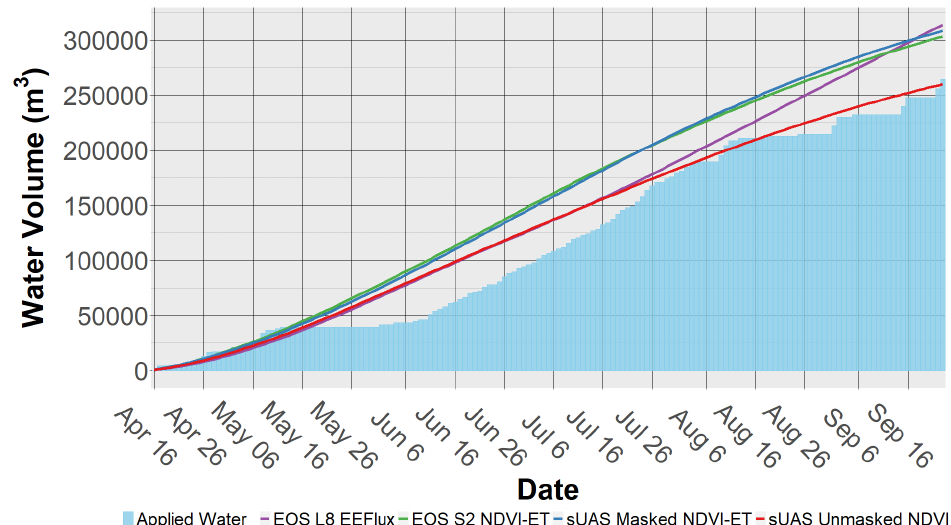
Figure 6. Cumulative ET a in m 3 (y-axis) interpolated from loess model fit. Landsat 8 EEFlux is colored purple, Sentinel 2 NDVI-ET is shown in green, sUAS masked NDVI-ET is blue, and sUAS unmasked NDVI-ET is red. Cumulative Applied Water from irrigation is shown in light blue